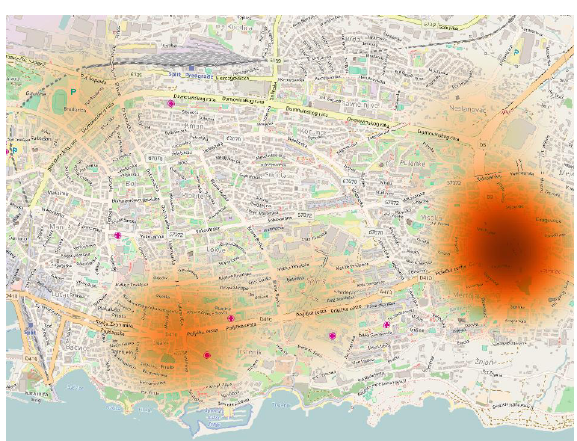
Figure 5: Animation snapshot: heat map renderer showing the number of visitors on 1st June 2015. (backdrop map © OpenStreetMap 2017)